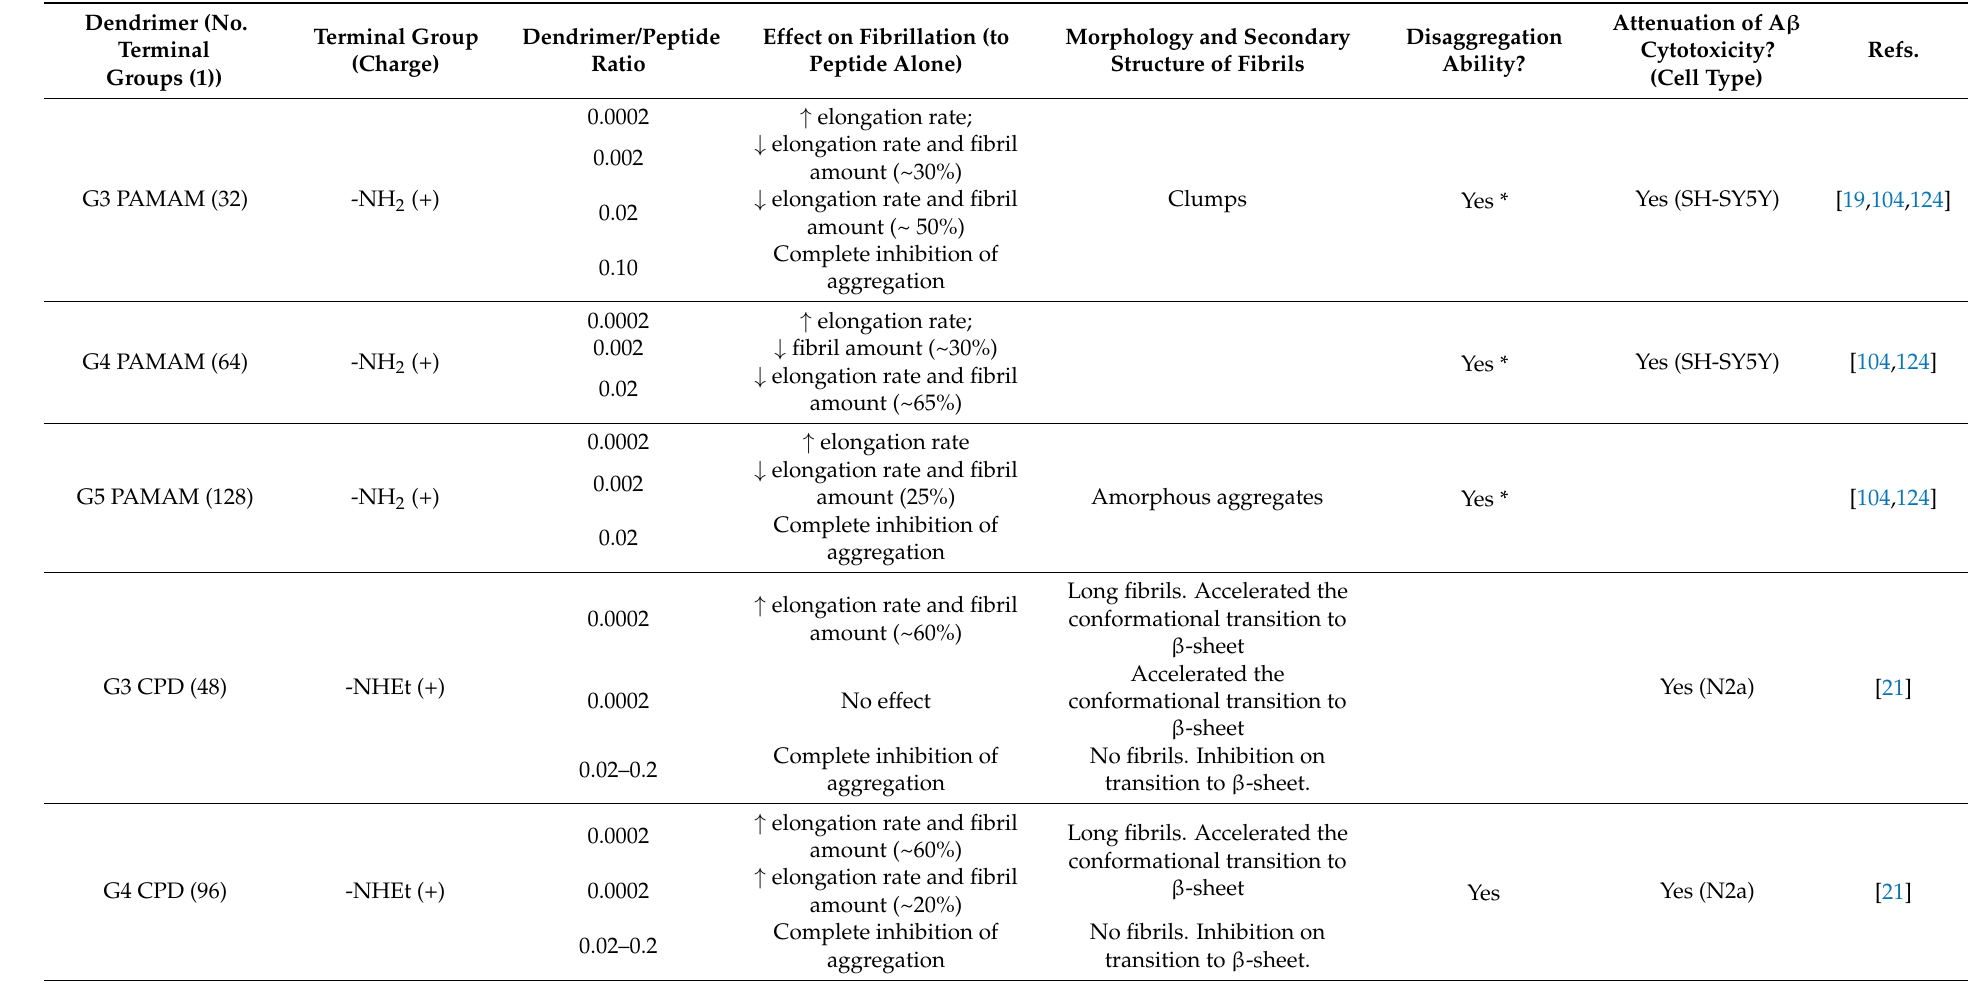
Table 1. Anti-amyloidogenic properties of dendrimers and derivatives towards A β